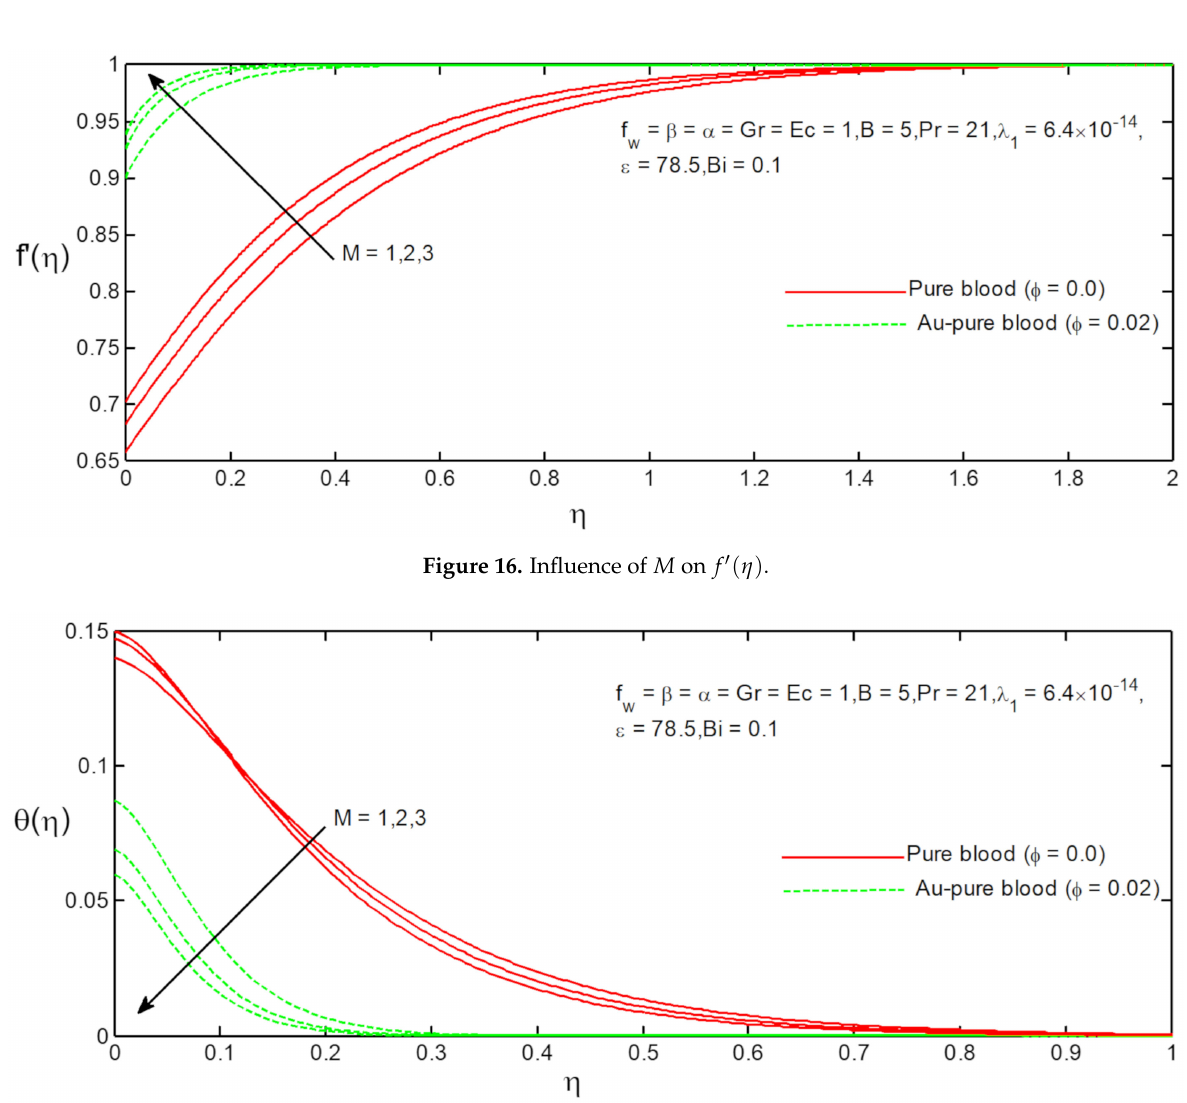
Figure 17. Influence of M on θ ( η )